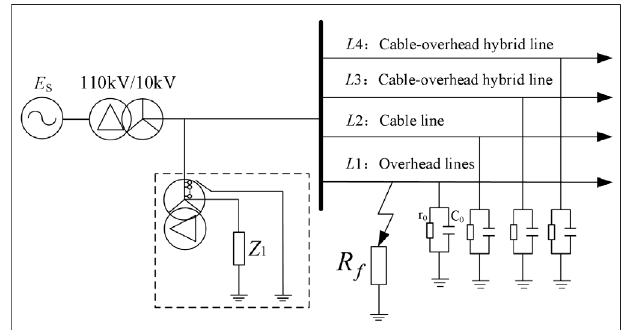
FIGURE 8 | Simulation model of voltage arc extinction with fl exible voltage